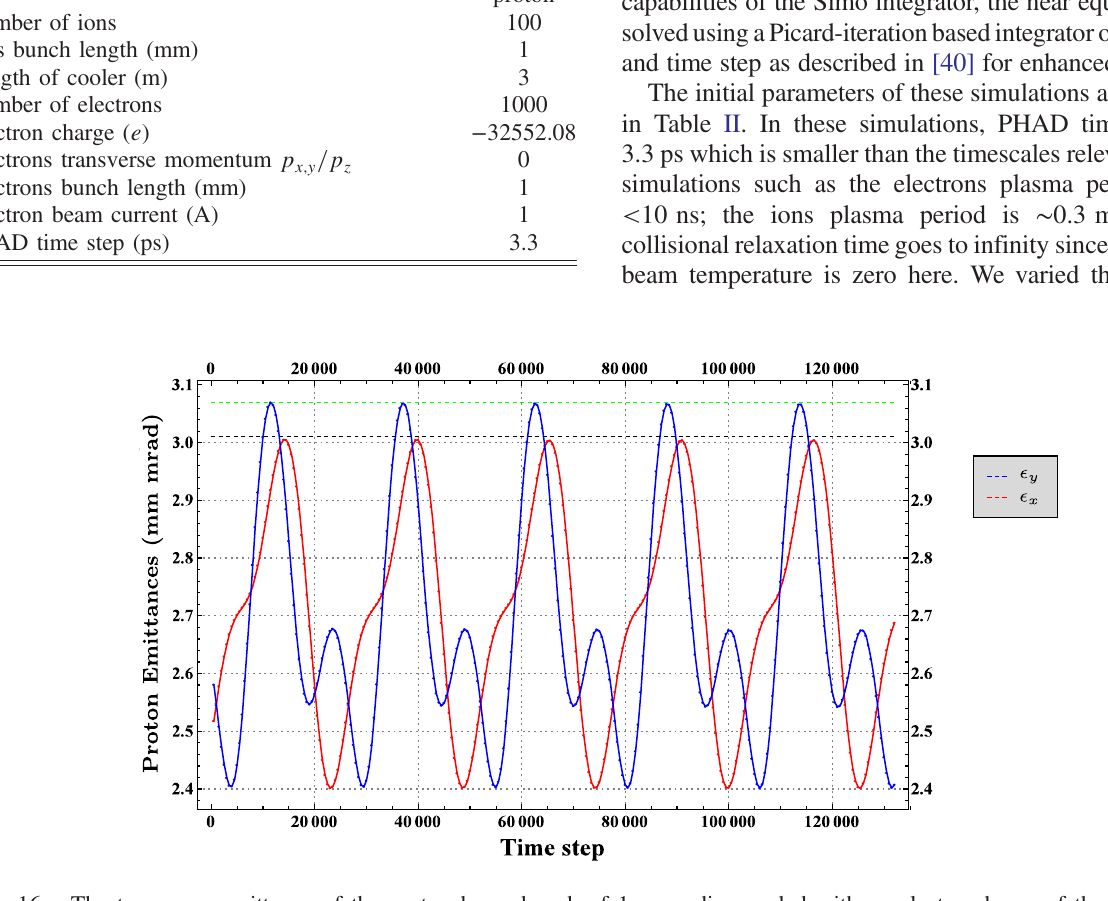
and ϵ , respectively. x y